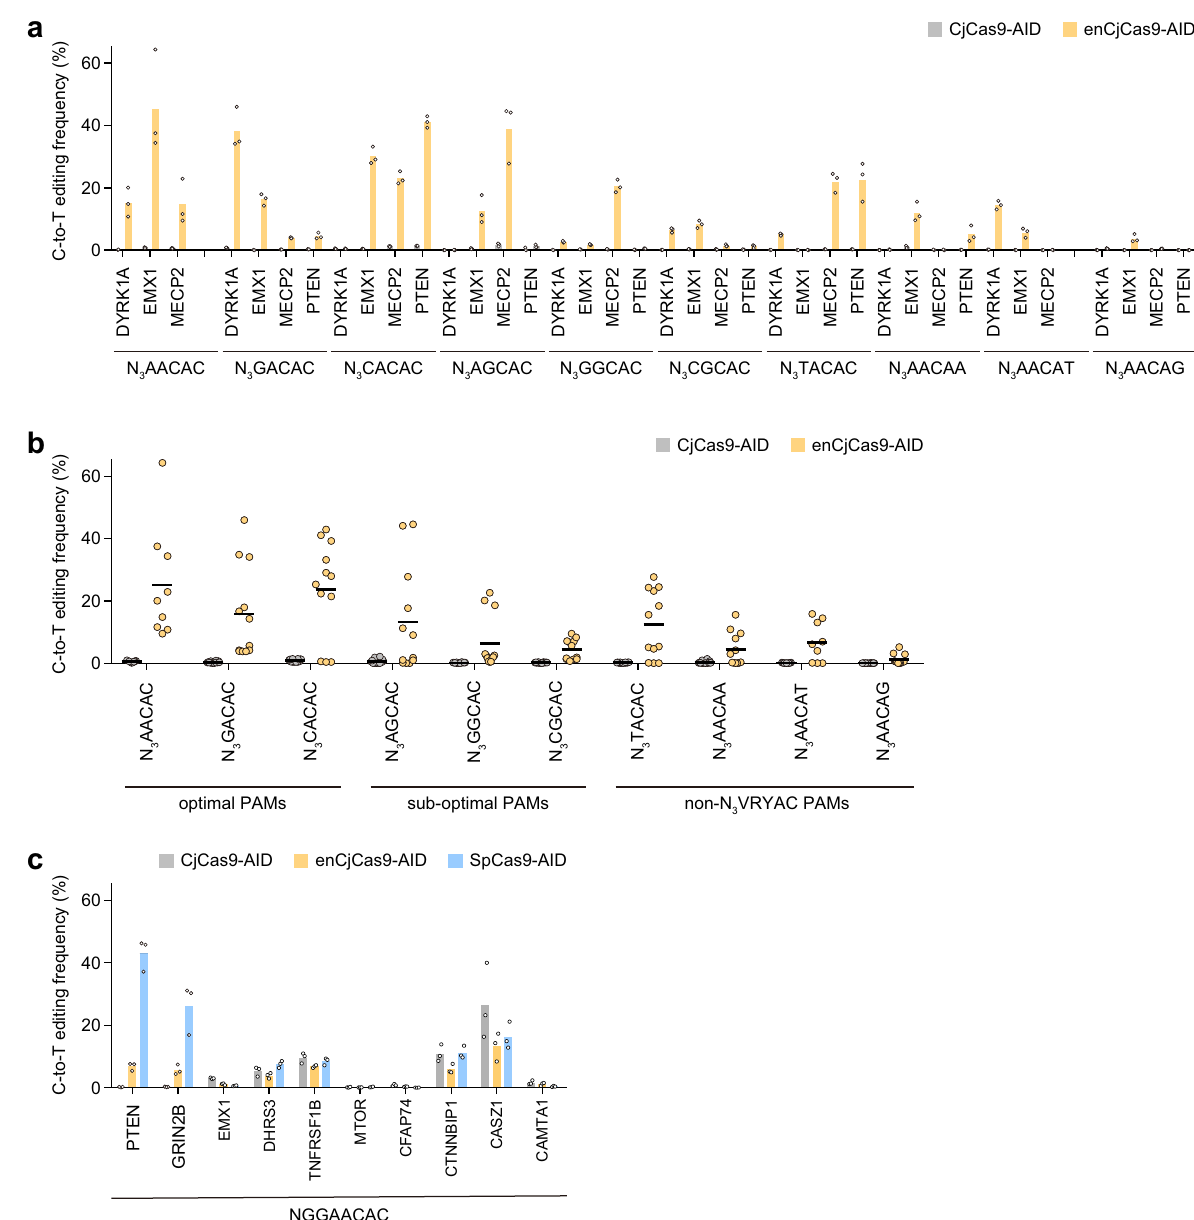
Fig. 3 Base editing by CjCas9-AID and enCjCas9-AID. ( a ) C-to-T conversion by CjCas9-AID (gray) and enCjCas9-AID (orange) at endogenous target sites in HEK293Ta cells ( n = 3). ( b ) Summary of the base-editing ef fi ciencies of CjCas9-AID (gray) and enCjCas9-AID (orange) in ( a ). Bars indicate medians. ( c ) C-to-T conversion by CjCas9-AID (gray), enCjCas9-AID (orange), and SpCas9-AID (blue) at endogenous target sites in HEK293Ta cells ( n =